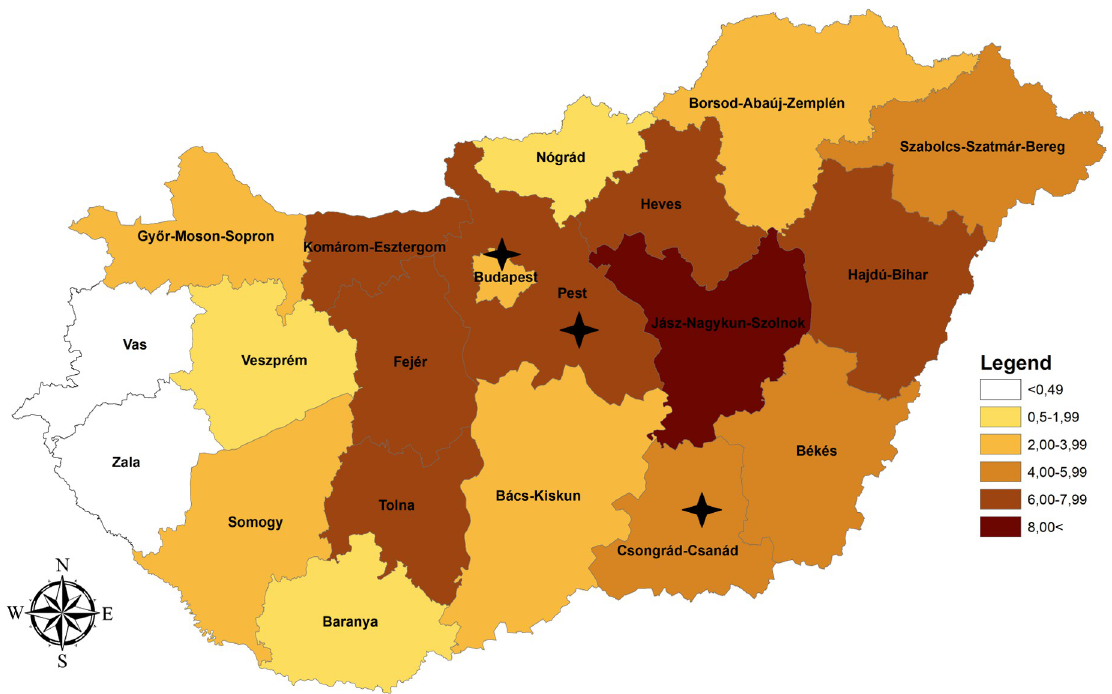
Fig 1. Geographical distribution of the West Nile virus seroprevalence data at NUTS 3 level in Hungary; 2019. NUTS 3 regions where Usutu virus seropositive blood donors (n = 5) were found are indicated by black asterisk.